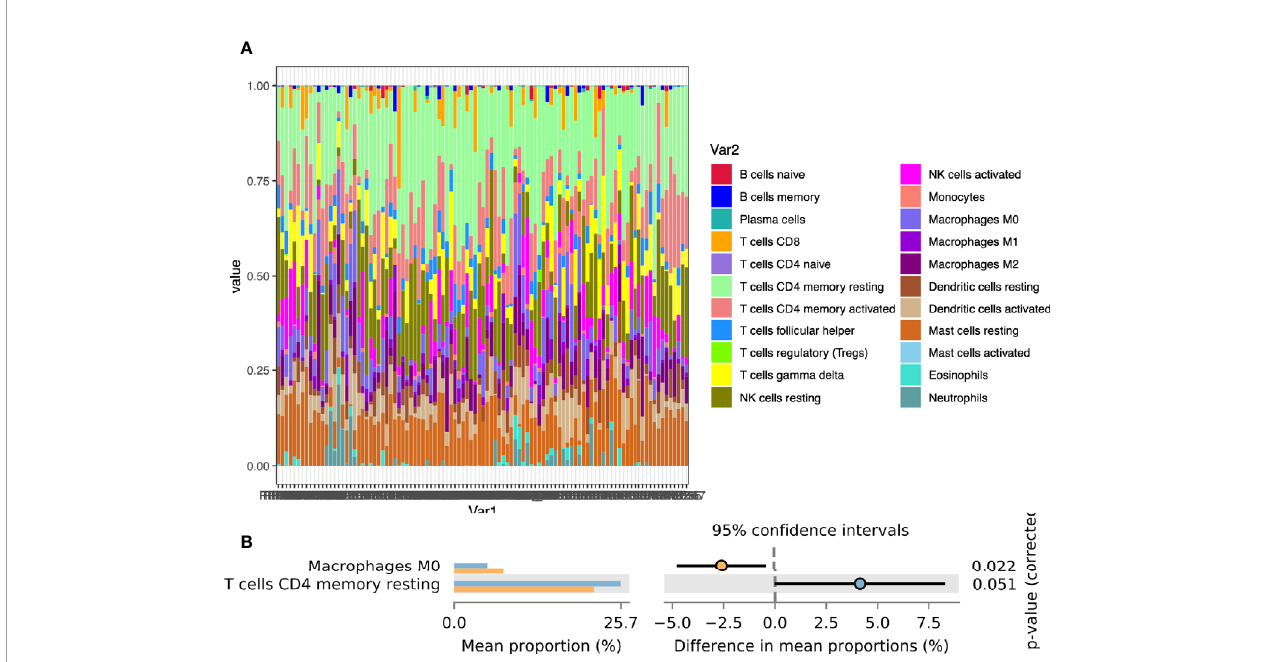
FIGURE 2 | Calculation of endometrial immune cells in fi ltration. (A) The composition of 22 immune cells in the CE group and the non-CE group; (B) Comparison of differences in immune cell